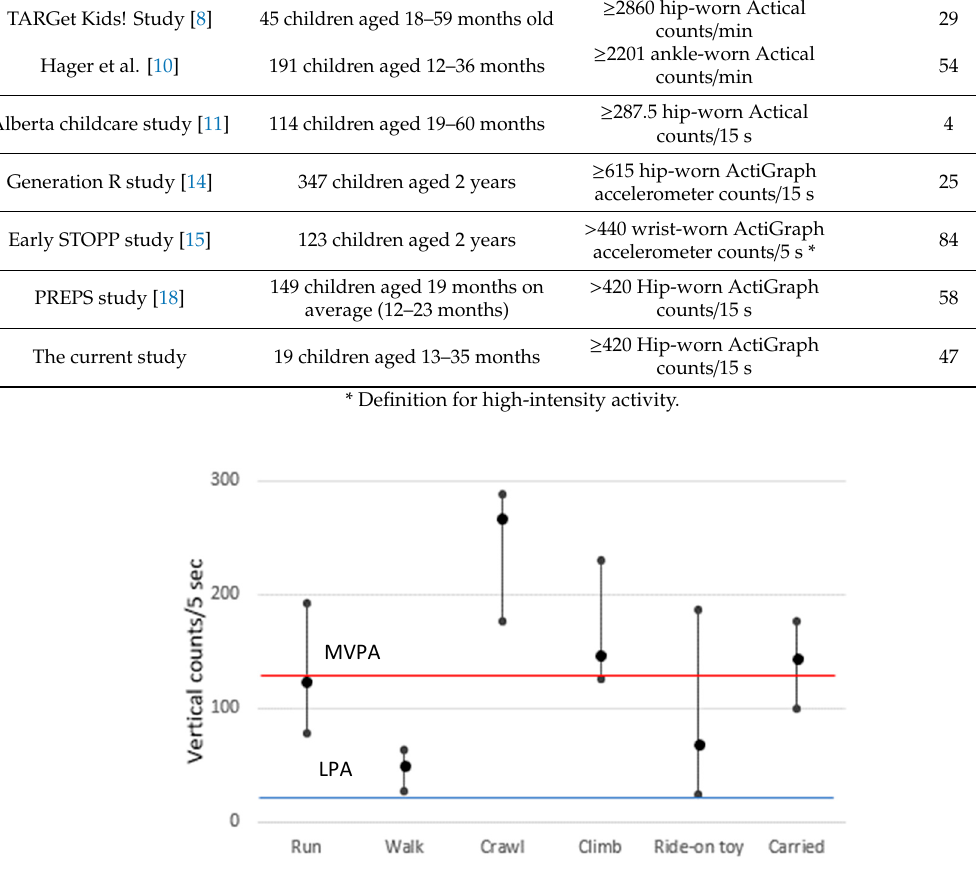
Figure 2. Median and Interquartile range of hip vertical accelerometer counts per 5 s (reproduction of the data published in Kwon et al.) [26]. * Note: The blue line indicates the lower threshold for LPA; the red line indicates the lower threshold for MVPA.